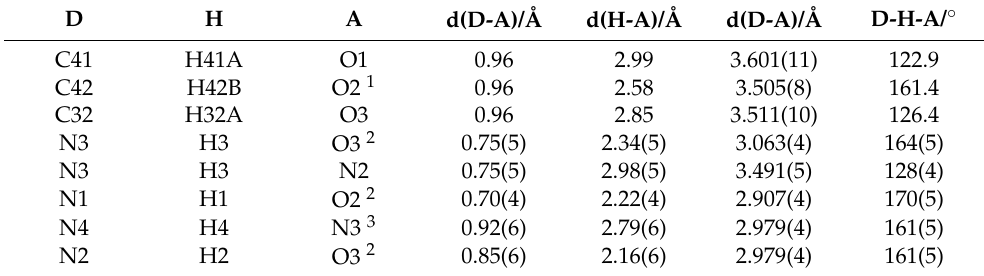
Table 3. Hydrogen bond distances in the crystal structure of